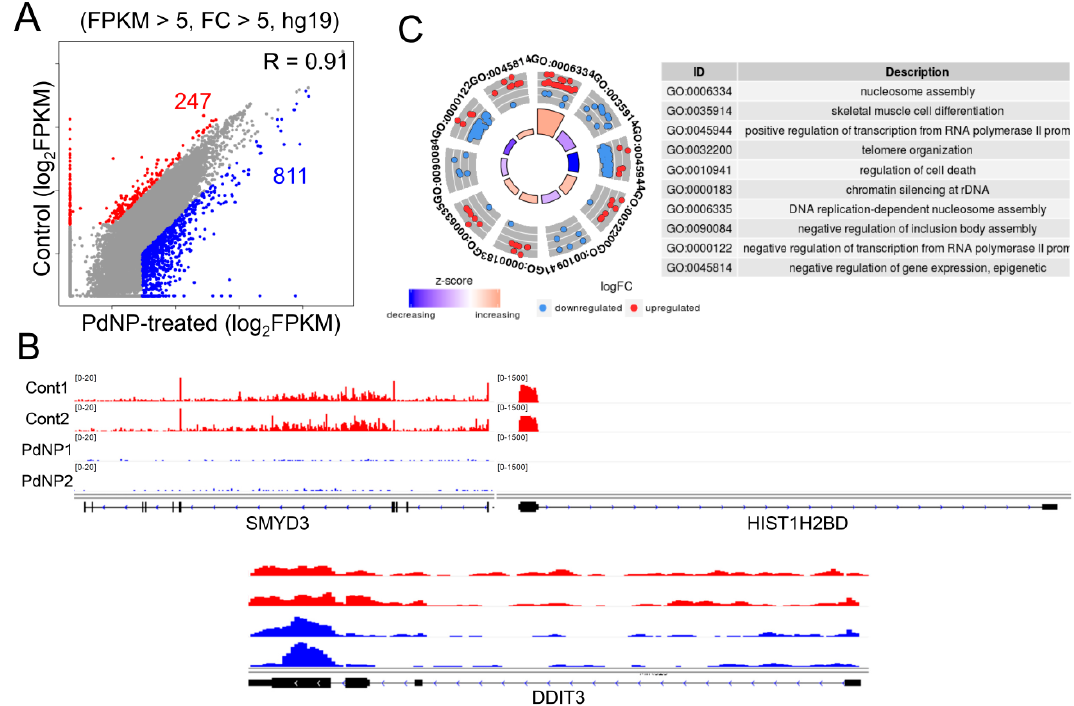
Figure 9. Palladium nanoparticle (PdNPs) exposure alters gene expression. ( A ) Scatter plot showing the downregulated (red dots) and upregulated (blue dots) genes after PdNPs exposure. Cutoff: FPKM > 5 and fold change (FC) > 5. ( B ) Integrative Genomics Viewer (IGV) images showing representative down- and upregulated genes. ( C ) GO-plot image of GO term analysis for all the differentially expressed genes (DEGs). Red dots and blue dots represent down- and upregulated genes, respectively. FPKM, fragments per kilobase of transcript, per million mapped reads.